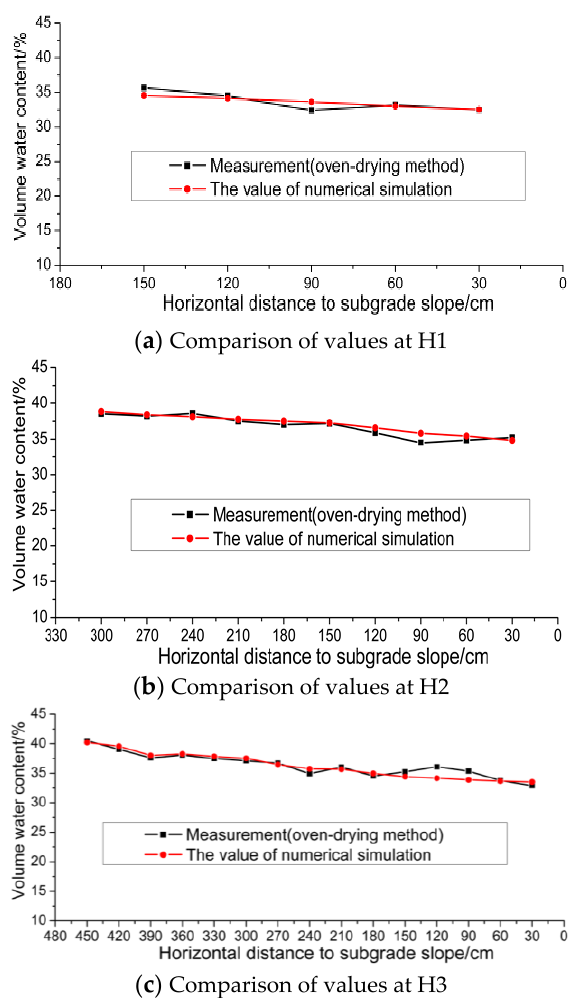
Figure 7. Comparison of measured and numerical calculated values. ( a ) Comparison of values at H1; ( b ) Comparison of values at H2; ( c ) Comparison of values at H3.